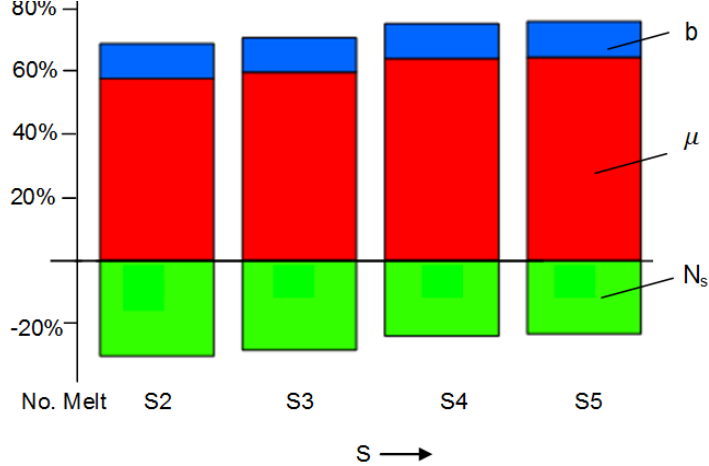
Figure 24. Sulfur intensity effect on the CT index through μ, N s and b (− CT decreases; + CT increases).